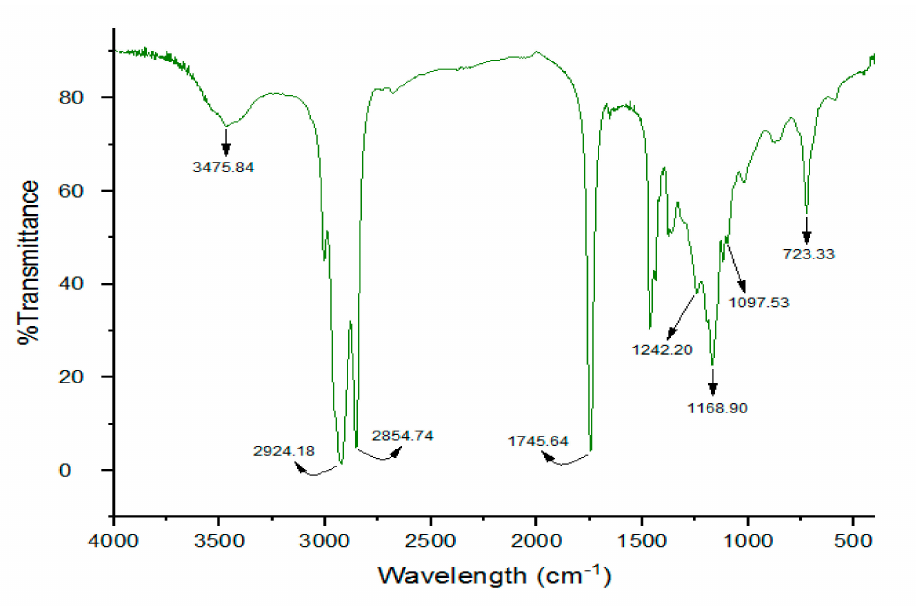
Figure 9. FTIR spectrum of MOOME